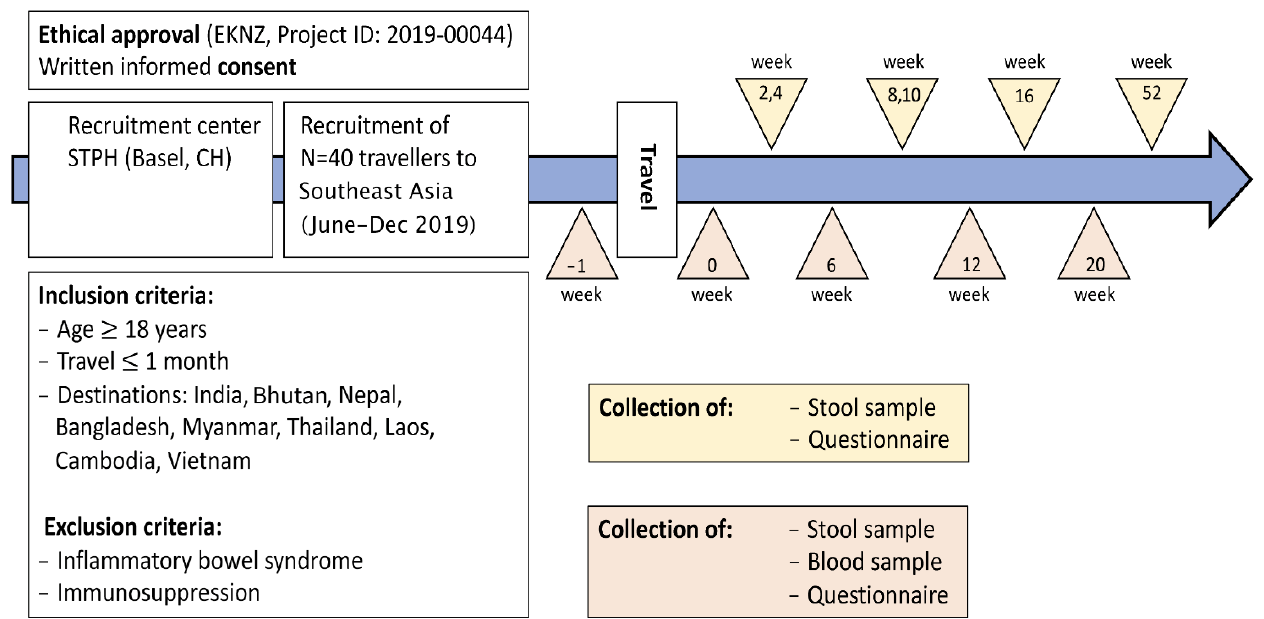
Figure 1. Study flow for patient recruitment and sample